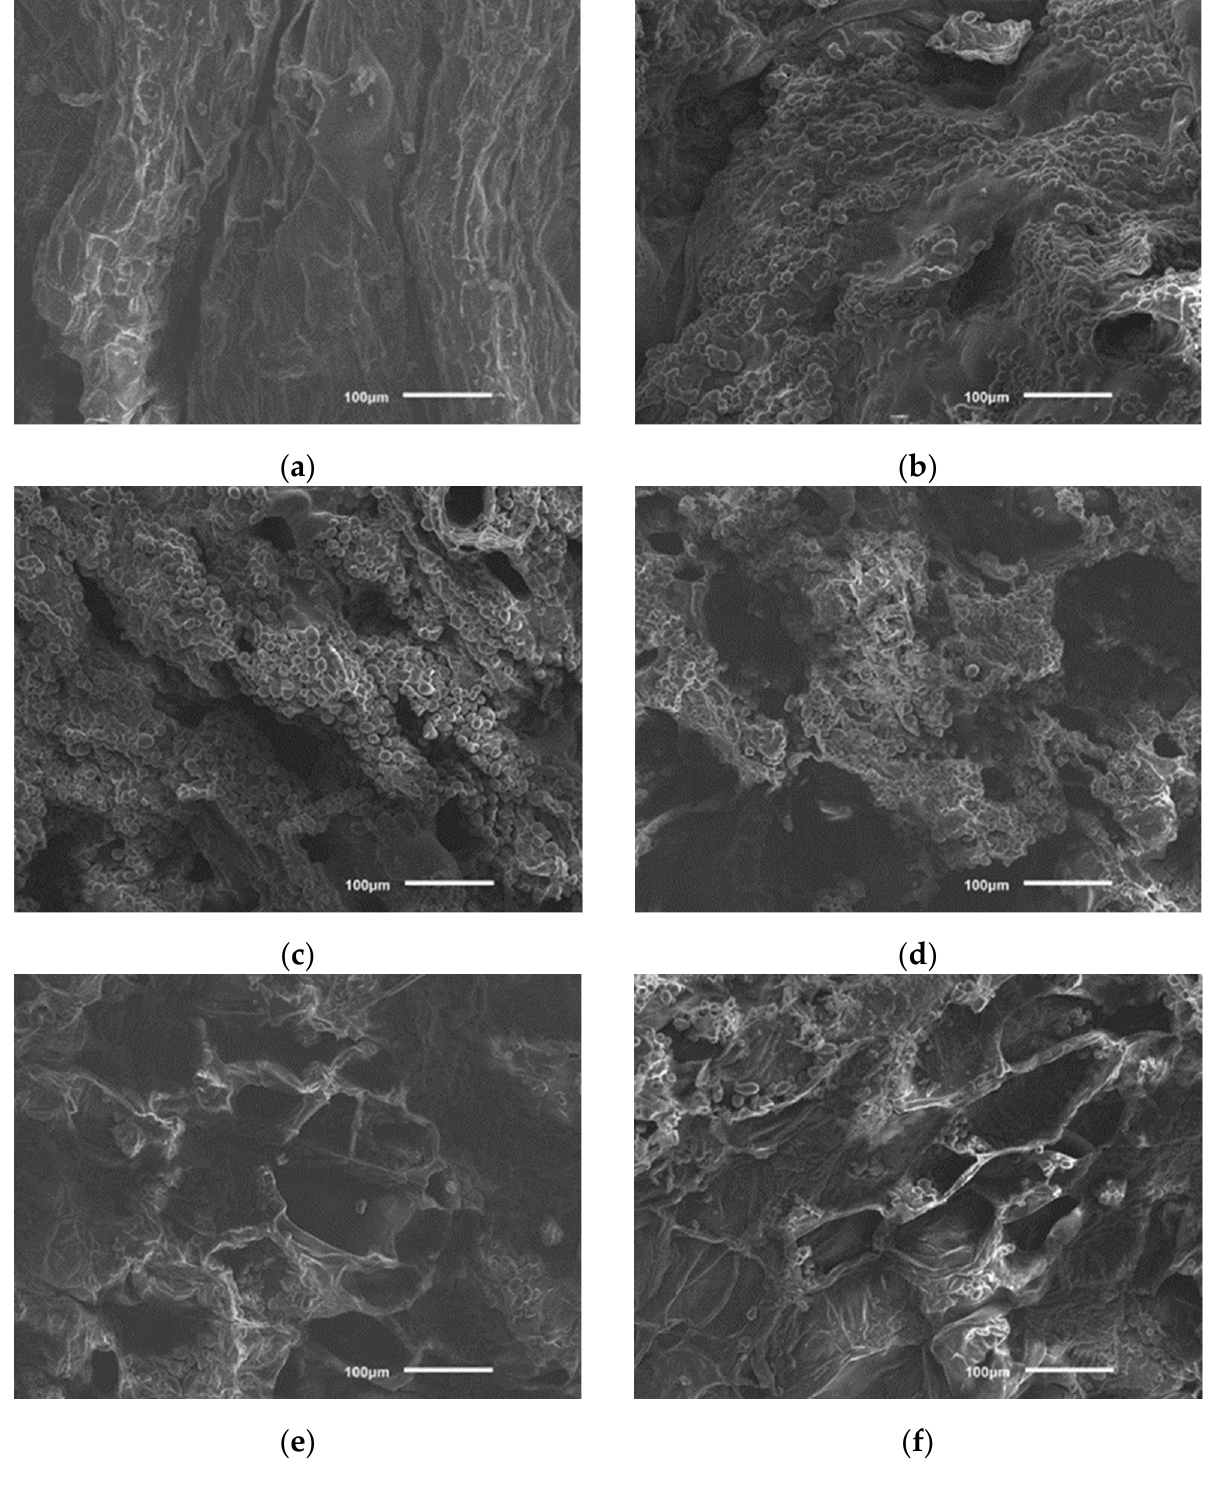
Figure 12. SEM images of Bo Chinh ginseng after drying: ( a ) heat pump drying 45 °C; ( b ) drying with intermittent ultrasound generator 45 °C + 120 W + 0.8; ( c ) drying with intermittent ultrasound generator 45 °C + 120 W + 0.6; ( d ) drying with intermittent ultrasound generator 45 °C + 120 W + 0.4; ( e ) drying with intermittent ultrasound generator 45 °C + 120 W + 0.2; ( f ) drying with intermittent ultrasound generator 45 °C + 120 W + 0.0.